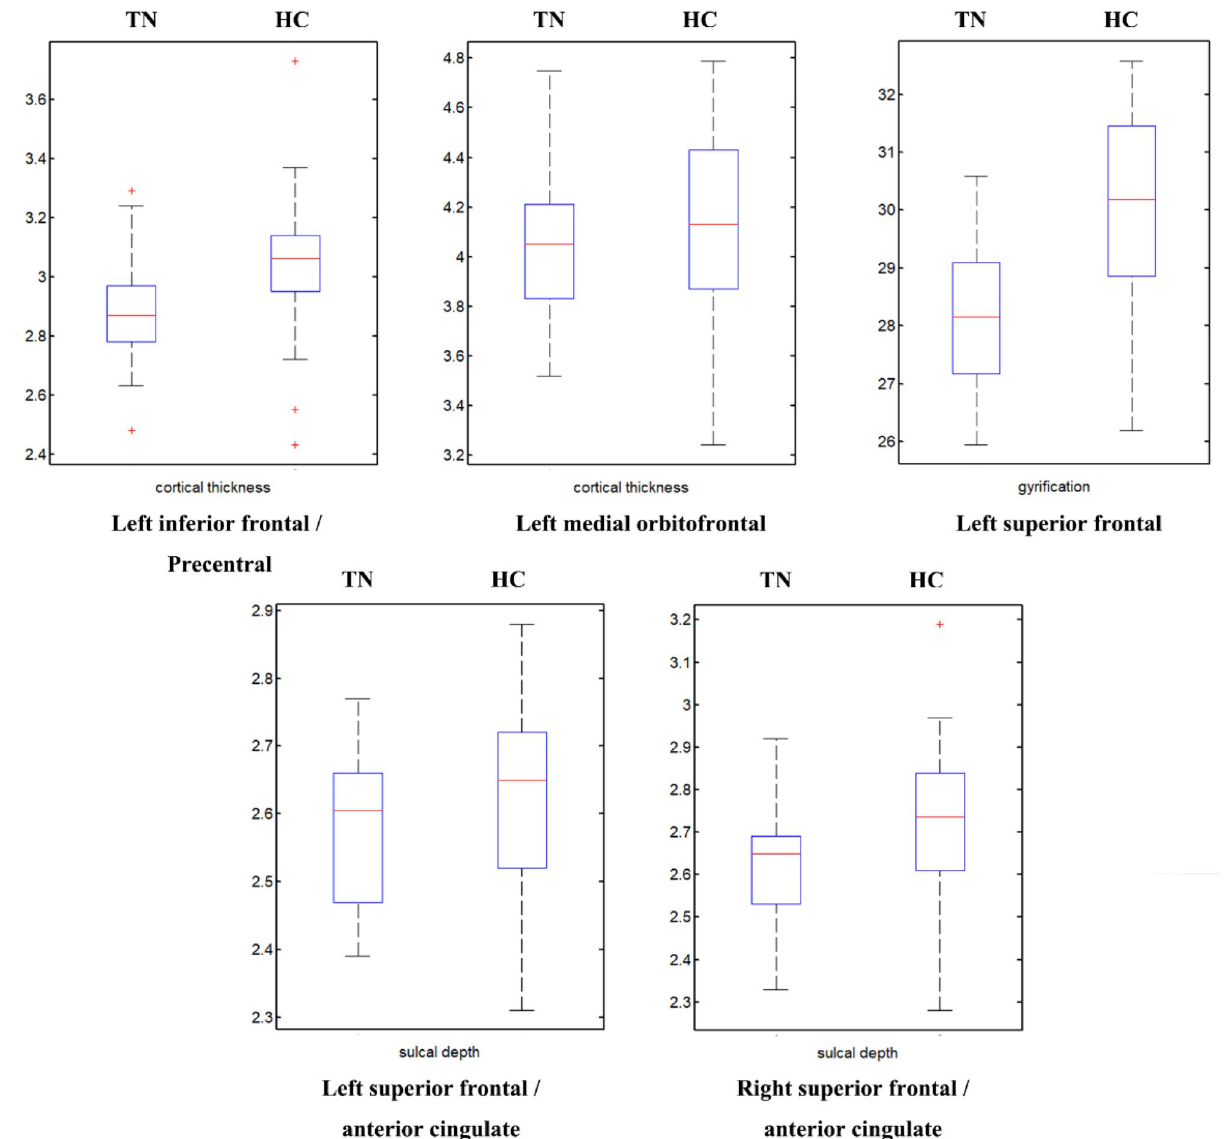
Figure 2. Box plots of clusters showing significantly changed cortical morphology in the trigeminal neuralgia (TN) patients compared to the healthy controls time that gray matter density decreased in the bilateral prefrontal cortex in patients with chronic low back pain. Fritz et al. 38 also reported decreased gray matter volume in the prefrontal cortex in chronic back pain patients, which was negatively correlated with pain intensity. And for TN patients, there are similar results 6,7,17,18 . Ober- mann et al. 7 identified specific brain regions possibly related to TN and found decreased gray matter volume in prefrontal cortex, anterior cingulate gyrus, orbitofrontal cortex and other regions in TN patients compared with the healthy control group. Tsai et al. 6 also reported that the volume of prefrontal cortex decreased in TN patients. Using surface-based morphometry, Parise et al. 17 found that there were abnormal changes (uncorrected) in corti- cal thickness in the frontal region of TN patients. Desouza et al. 18 found that the anterior cingulate cortex and orbitofrontal cortex were thinner in TN patients. A study of Schmidt-Wilcke et al. 39 about chronic facial pain have shown a decrease in gray matter volume in the anterior cingulate region and demonstrated that the anterior cingulate connects the prefrontal cortex to the limbic system, which is associated with pain regulation. Thus, the observed decrease in cortical morphology in the prefrontal and anterior cingulate regions may reflect a highly pain-related response to chronic pain, including TN. Considering the functional correlation between the two regions, the interregional connections between the prefrontal cortex and the anterior cingulate cortex appear to form part of the central pain processing system, responsible for pain regulation and perception. In addition, it was found that compared to the HC group, the cortical thickness decreased in the left precentral gyrus of TN patients. As a part of the primary motor cortex, the precentral gyrus is responsible for reflecting sensory pain response, maxillary motor inhibition, and facial muscle tension 40 . Hayes and Northoff 41 previously reported that painful stimuli could activate the motor cortex. One previous study of Peck et al. 42 has proposed